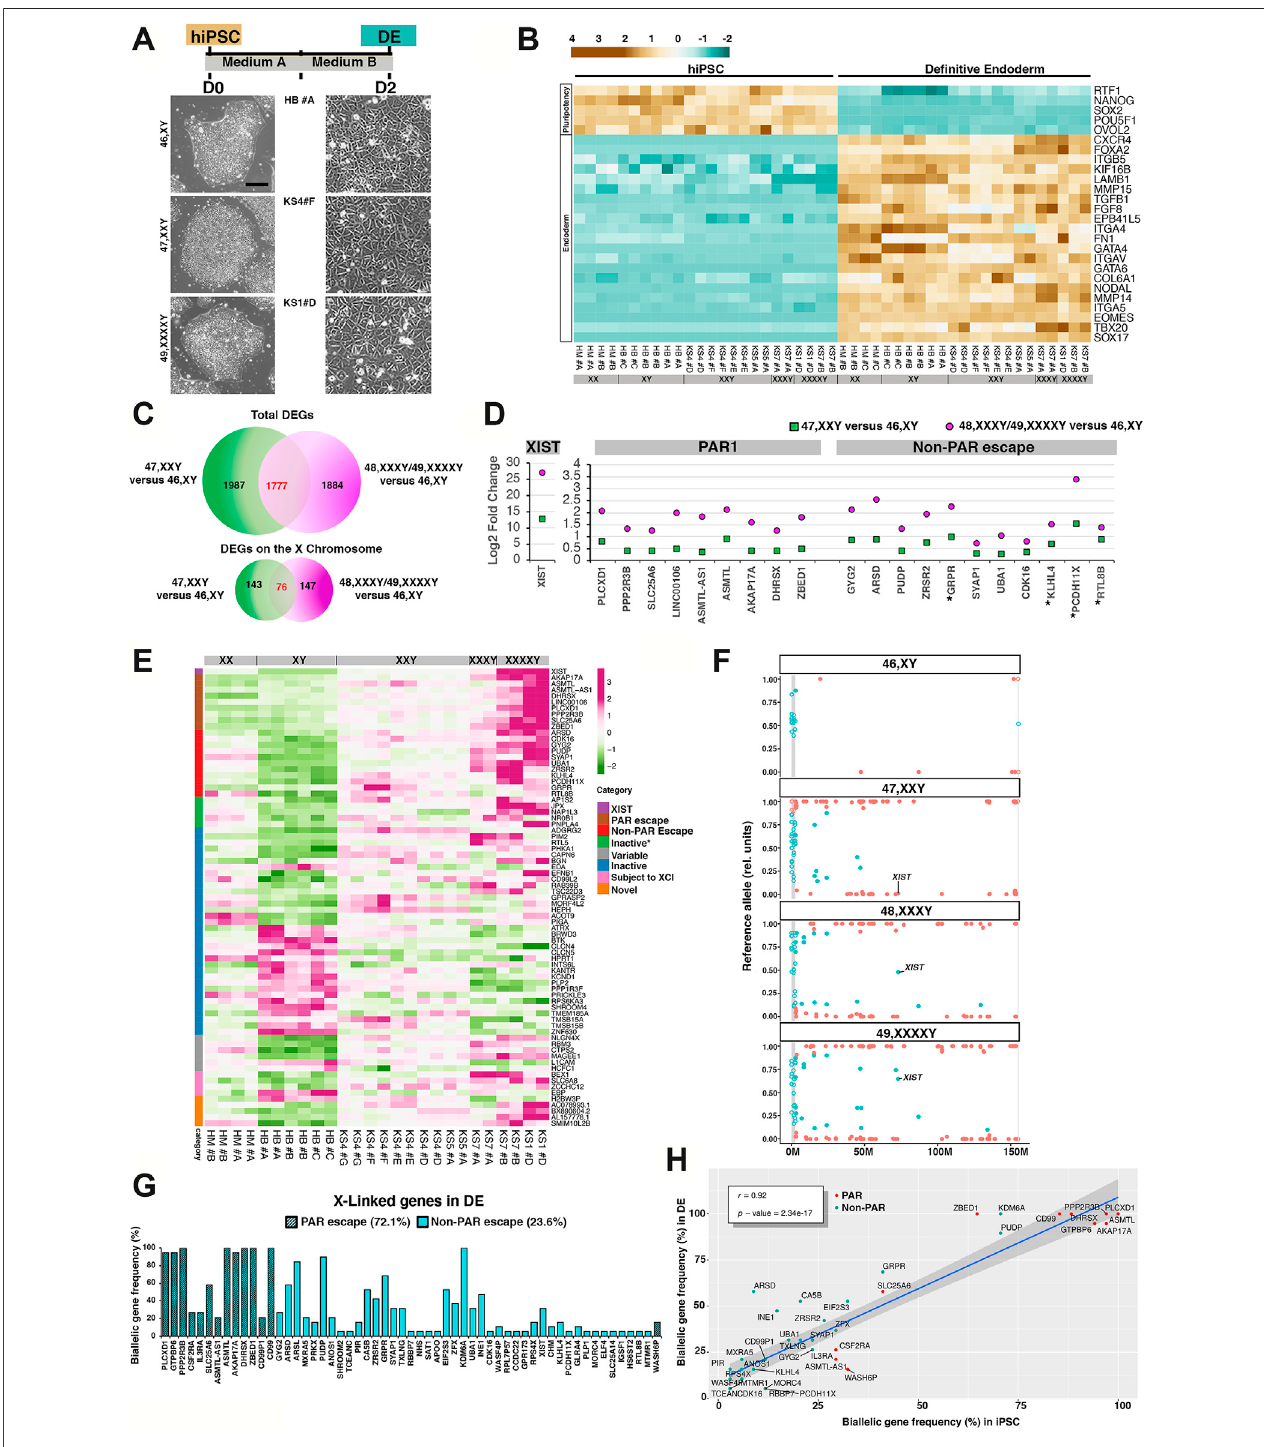
FIGURE 5 | Gene expression pro fi les and ASE analysis of iPSC-derived de fi nitive endoderm (DE) cells. (A) Top: Schematic showing the DE differentiation timeline. Bottom: Representative morphologies of hiPSCs (left) and differentiated DE counterparts (right). Scale bar, 200 µm. (B) Heatmap illustrating the FPKM expression of pluripotency genes and DE-speci fi c markers in the indicated hiPSCs and DE cells. (C) Venn diagram analysis of global (upper Venn) or X chromosome-restricted (lower Venn) up- and downregulated DEGs from the comparisons 47, KS versus 46,XY and 48/49, HGA versus 46,XY. (D) Log 2 fold change of shared dosage-sensitive X-linked DEGs across the two comparisons of 47,XXY versus 46,XY (green) and 48/49, HGA versus 46,XY (purple). Two groups of DEGs are shown: genes from the PAR1 and non-PAR biallelic genes escaping Xi (Escape) in our iPSC cohort. DEGs indicated by asterisks have been previously described as inactive ( KLHL4 ), variable